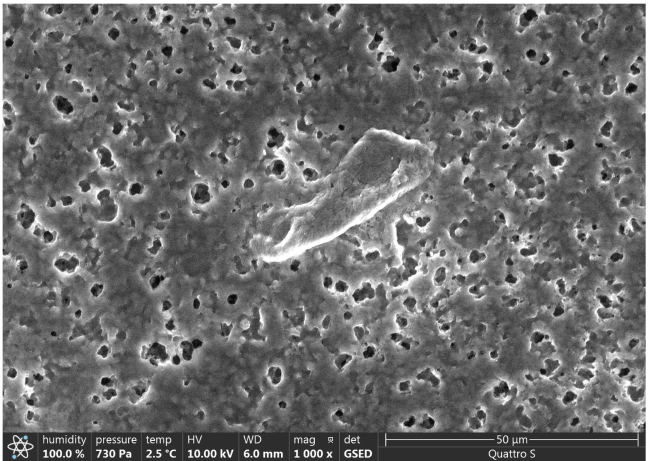
Figure 7. Illustration showing the magnification of Product L (1000 × ). A particle of >50 µ m was observed.